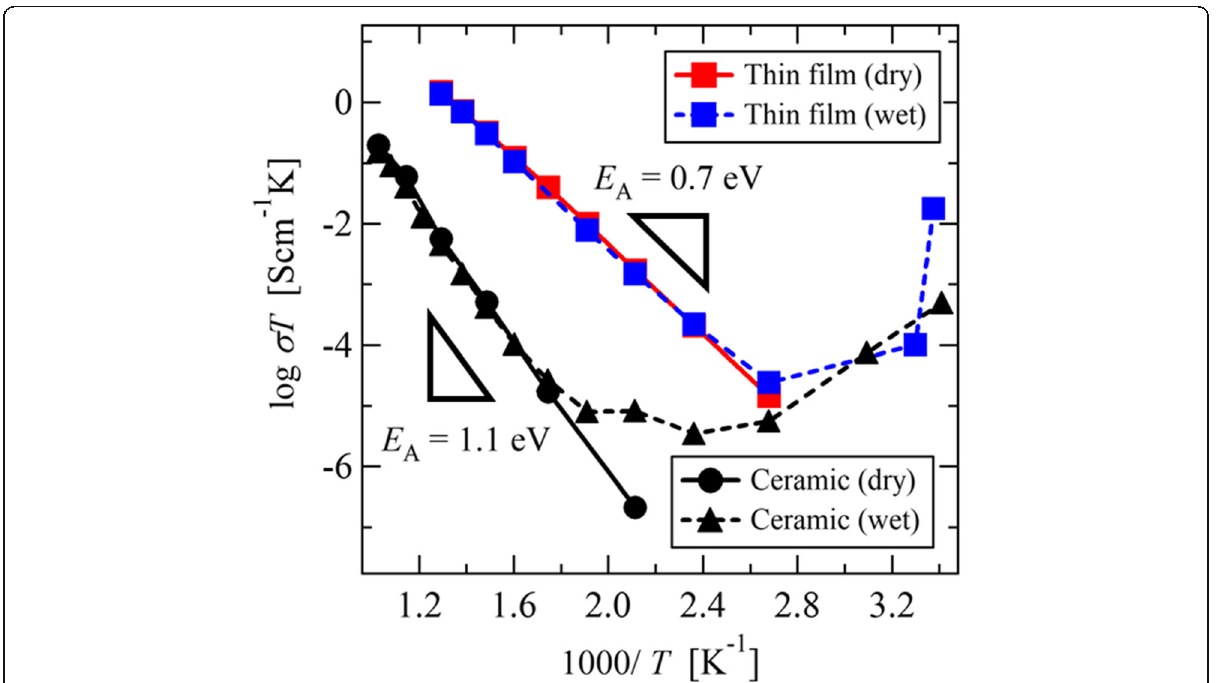
Fig. 3 Arrhenius plots of the electrical conductivities in the in-plane of the SDC thin films and bulk ceramics, measured in dry and wet